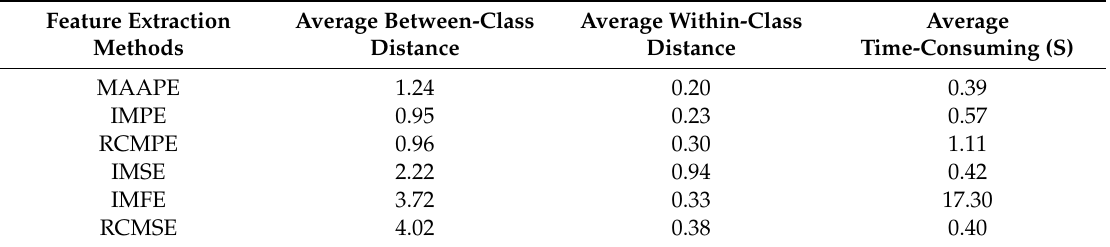
Table 2. Performance comparison of rolling bearing fault feature extraction algorithms.